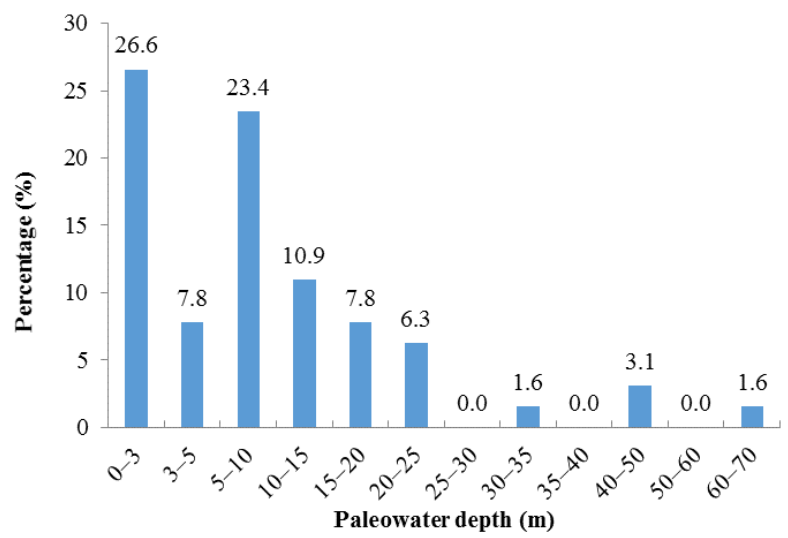
Figure 8. Distribution histogram of paleodepths of the Guantao formation in the Liaodong sub- uplift.